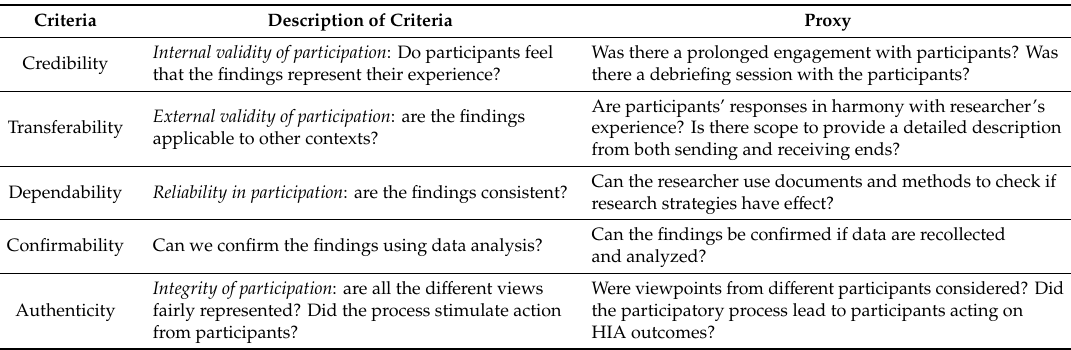
Table 3. Description of quality